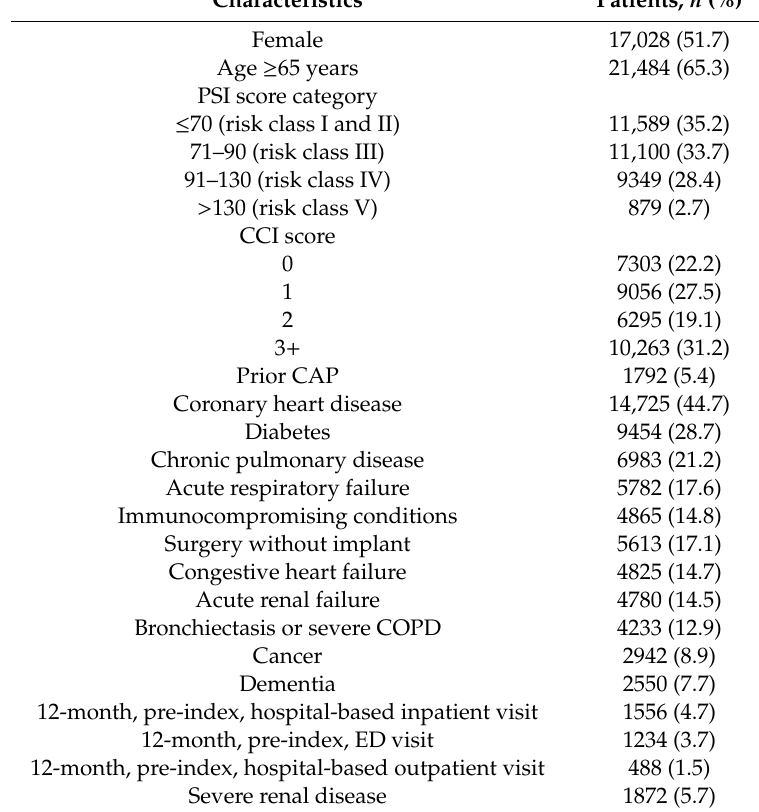
Table 1. Characteristics of study population ( n =